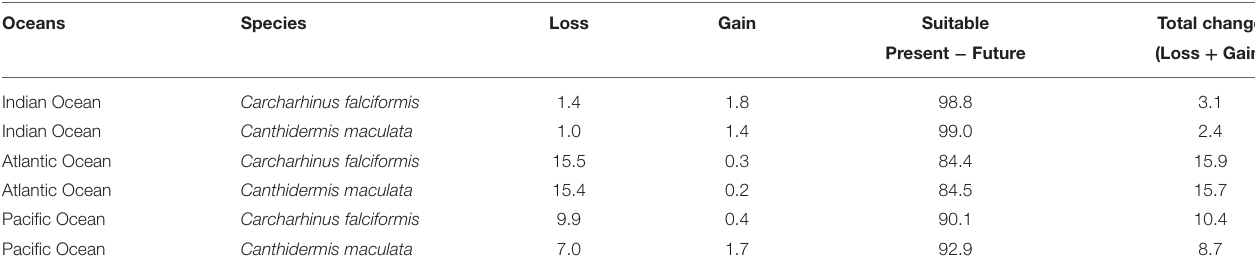
TABLE 5 | Predicted changes in habitat suitability areas (in %) by the year 2100 for the A2 scenario of climate change for both by-catch species. Oceans